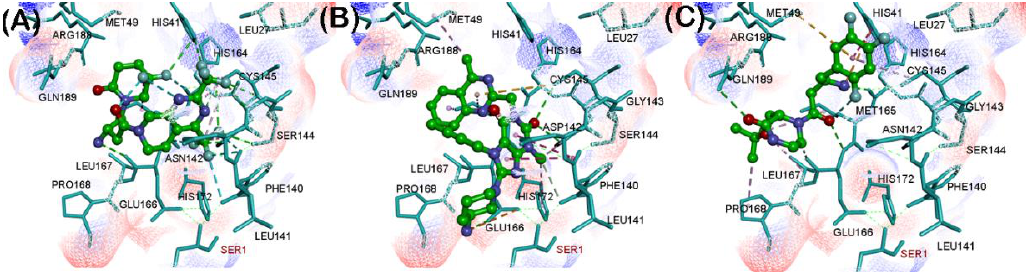
Figure 4. Binding modes of two molecules of DPP4 inhibitor gemigliptin (CPK cartoon) in the SARS-CoV-2 M pro dimer (PDB ID: 6Y2G). Domains I–III are shown along with catalytic site amino acids His41 and Cys145. Hydrogen atoms are not shown to enhance clarity.